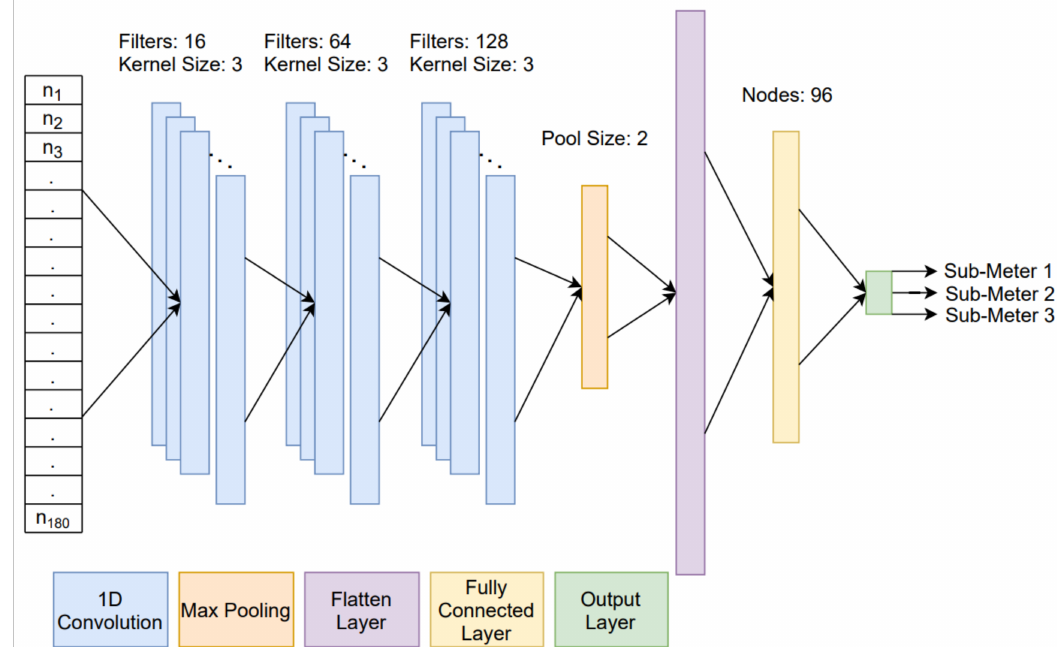
Figure 2. CNN model architecture.